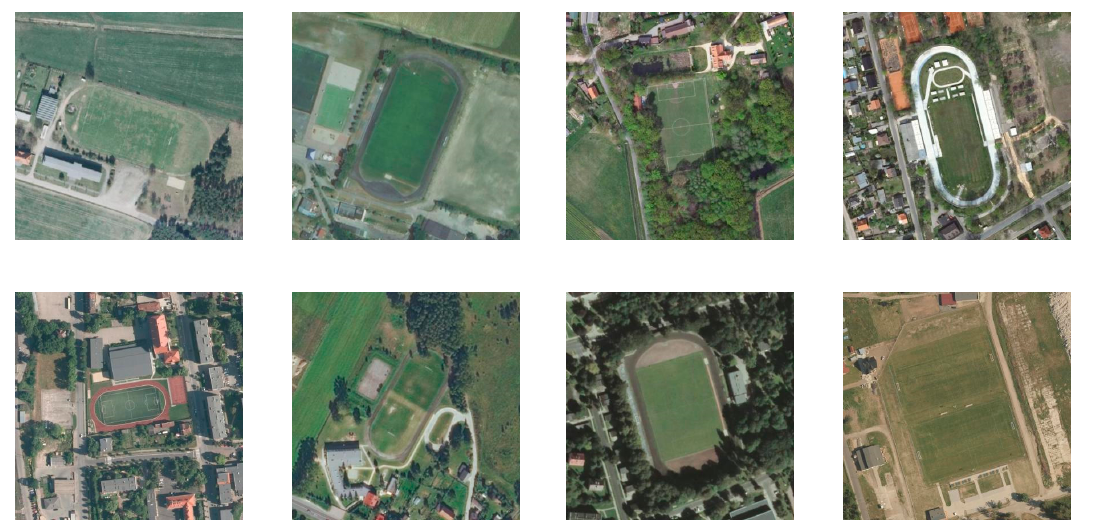
Figure 2. Samples of the training dataset.